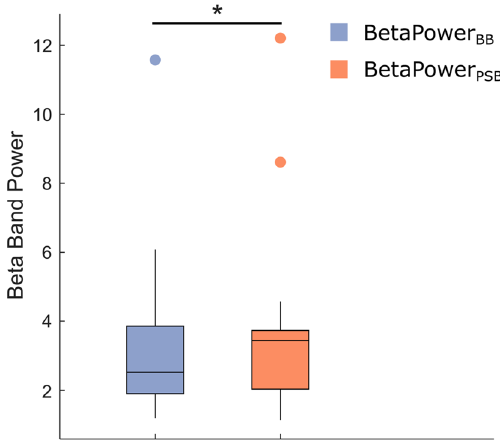
Figure 3. Changes in beta band activity. Box plot of the average power estimated in beta band (area under the curve, averaged over S1 channels) for EEG epochs recorded at C3, C4, CP3 and CP4 during balance trials before (purple) and after (orange) the vibratory stimulation. Significance ( p < 0.01) is indicated by the asterisk and results are reported for 45-s long